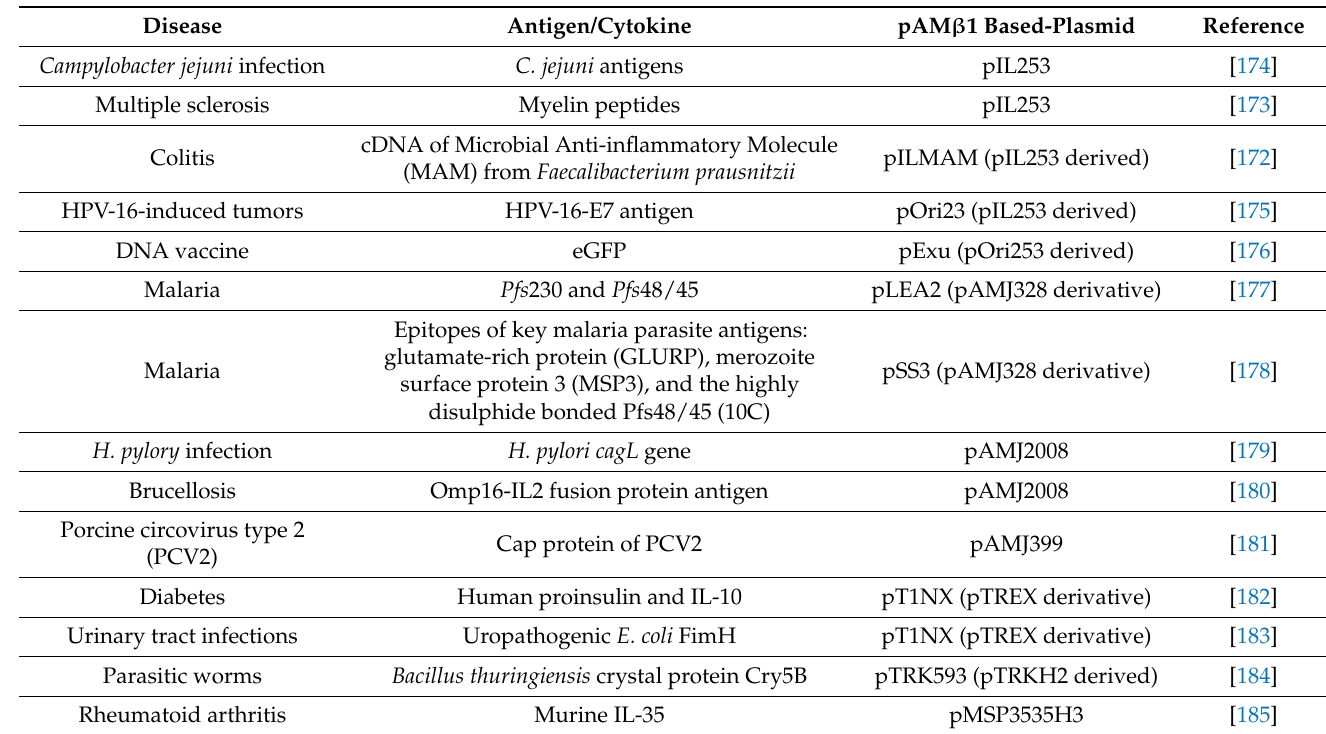
Table 4. Plasmids with a pAM β 1 origin of replication used as antigen-expressing vectors in L. lactis host, for mucosal vaccination purposes against several